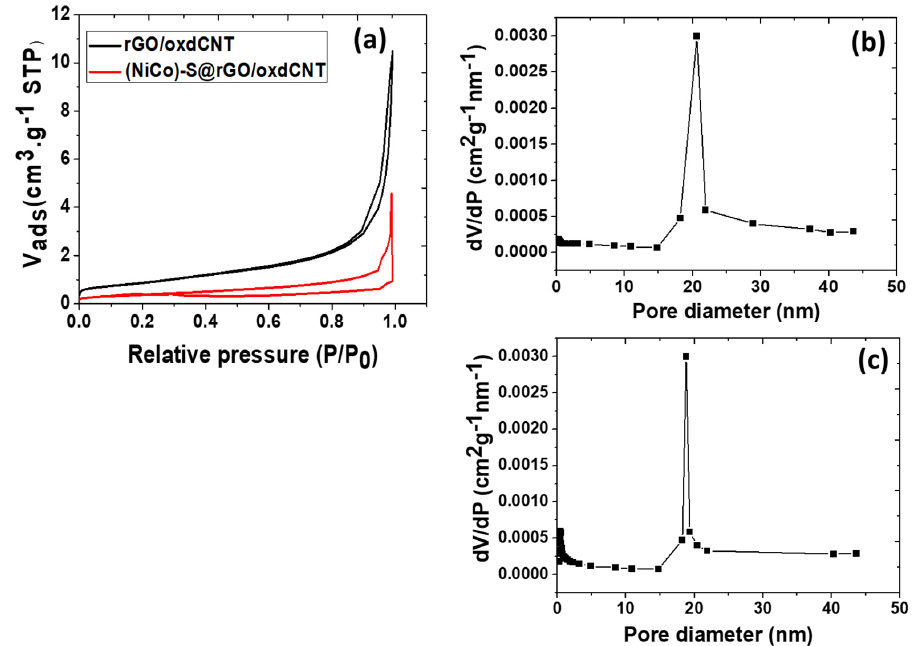
Figure 3. Nitrogen adsorption–desorption isotherms of rGO/oxdCNT and (NiCo)–S@rGO/oxdCNT ( a ). Pore-size distributions of rGO/oxdCNT ( b ) and (NiCo)–S@rGO/oxdCNT ( c ) powders. The crystalline nature of oxdCNT, rGO and (NiCo)–S@rGO/oxdCNT were investi- gated by XRD. As seen in Figure 4, the diffraction peaks at 2 θ ≈ 10.27 and 26.1° originate from the rGO [20]. A strong diffraction peak of functional CNT was formed at 2 θ ≈ 25°. The low-intensity peaks were formed at 2 θ ≈ 32.5° and 43° can be attributed to the graphite (Figure 4a). It was also observed in the XRD patterns (Figure 4b) that the dominant phase formed was NiCo 2 S 4 (PDF 020-0782) as evident by the appearance of the characteristic peaks at 2 θ = 26.7 ◦ , 31.6 ◦ , 38.3 ◦ , 47.5 ◦ , 50.7 ◦ and 55.3 ◦ , which correspond to (220), (311), (400), (511), (440), and (731) planes, respectively [24,29]. The three minor peaks at 2 θ = 29.8 ◦ , 47.5 ◦ and 52 ◦ can be assigned to be the (311), (511) and (411) planes of Co 9 S 8 (PDF 073- 1442). In addition, the characteristic diffraction peaks of the NiS phase (PDF 020-1280) well defined at 2 θ = 34.7 ◦ , 46 ◦ , 53.5 ◦ , 62.7 ◦ and 65.4 ◦ correspond to the (101), (102), (110), (200) and (201), respectively [40]. To determine the chemical composition of the as-prepared, XPS measurements were carried out (Figure 5a–d). The XPS survey spectra (Figure 5a)